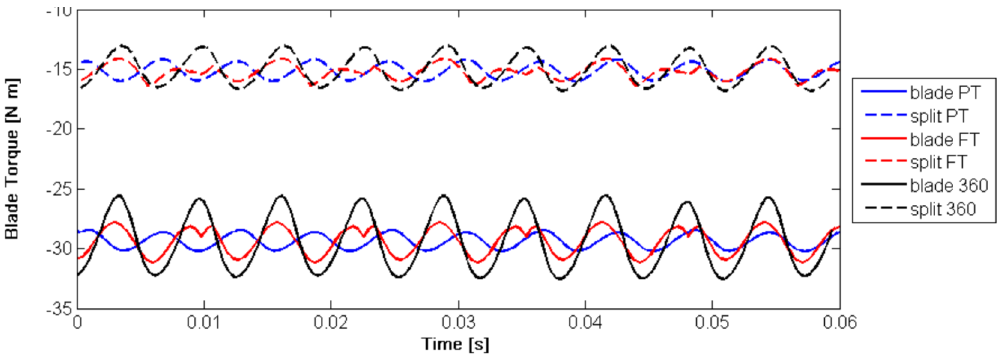
Figure 24. Variation in the blade and splitter torque in a model Francis turbine under the BEP operating conditions; PT ‐ profile transform, FT ‐ Fourier transform, 360 ‐ complete turbine modeling [6].